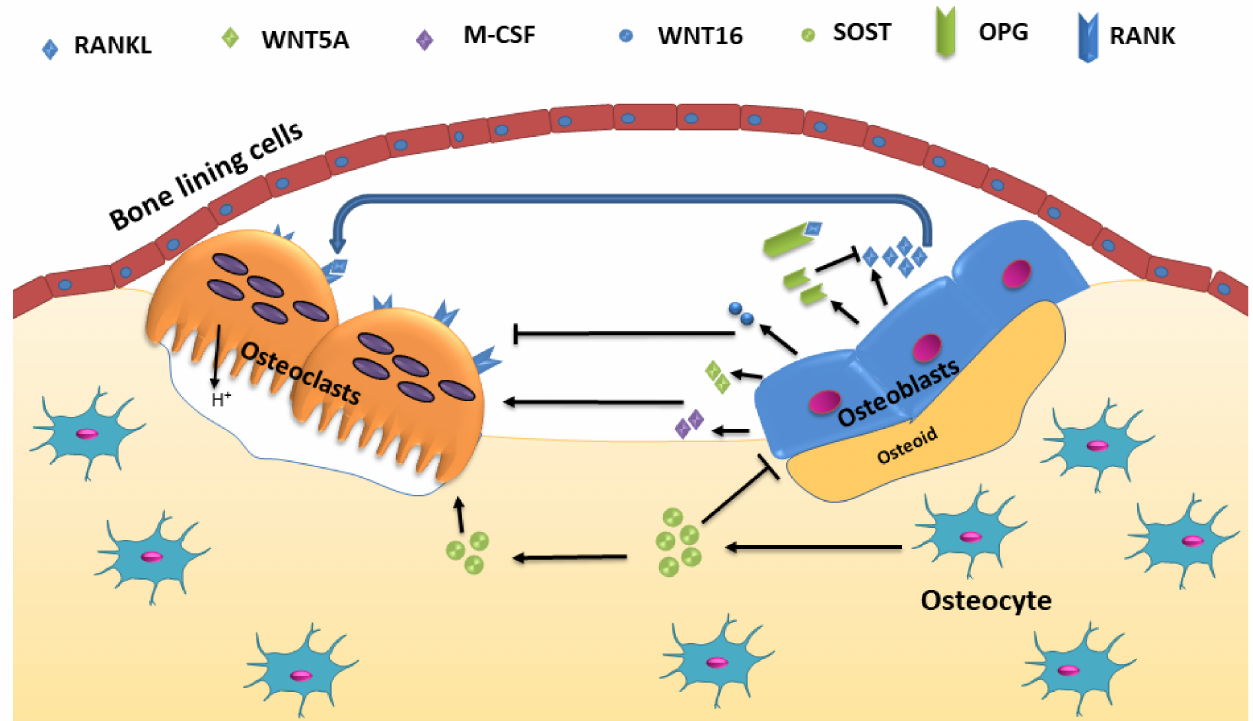
Figure 1. Cellular and molecular interplay during bone remodeling. M-CSF, RANKL produced by osteoblasts positively regulates while WNT5A/16 and OPG negatively regulates osteoclast function. SOST produced by osteocytes embedded in bone matrix positively and negatively regulates the osteoclast and osteoblast functions,